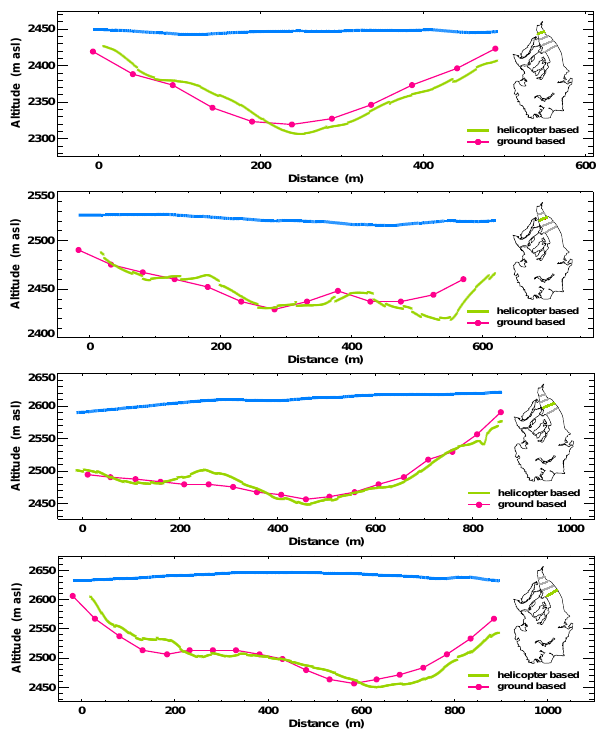
Fig. 4. Comparison of ground-based and helicopter-based GPR pro- files. Four GPR profiles of the lower part of Glacier de Corbassi`ere were